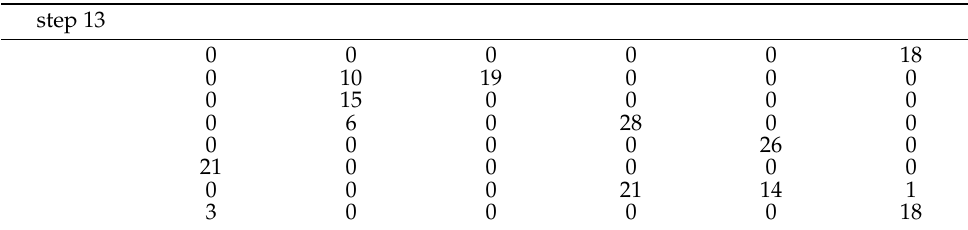
Table 5. Results of subsequent iterations and feasible solution for row minimum